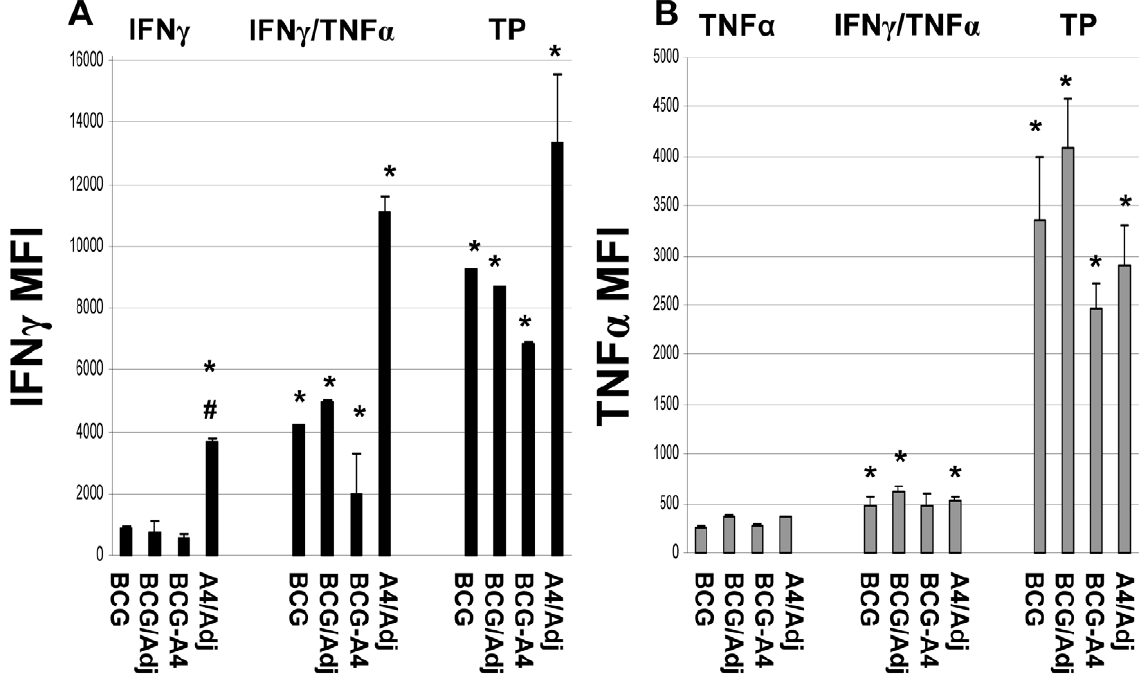
Figure 3. Median fluorescence intensity (MFI) of (A) IFN c or (B) TNF a in monofunctional or multifunctional CD4 T cells. The data are presented as the mean of individual MFI values for 4–5 mice per vaccine group. * Significant differences relative to monofunctional cytokine expressing cells, p , 0.05. # Significant differences relative to BCG in the same T cell subset, p , 0.05.